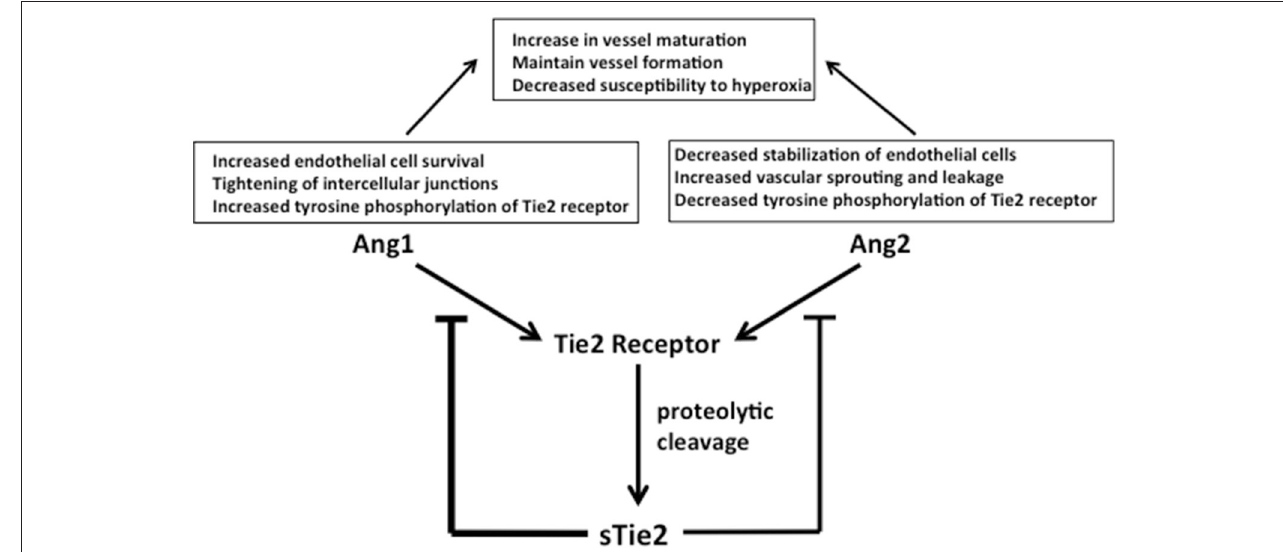
FIGURE 4 | Ang1 and Ang2 function and regulation. Ang1 and Ang2 control competitive regulatory events in the vascular endothelium. Competitive binding to their common receptor, Tie2, regulates endothelial cell stability and function to inhibit or promote neoangiogenesis, respectively. Ang1 increases endothelial cell survival, tightens intercellular junctions, and increases tyrosine phosphorylation of membrane-bound Tie2. Ang2 decreases endothelial cell stability, increases vascular sprouting and leakage, and decreases tyrosine phosphorylation of Tie2, promoting angiogenesis. The resulting competitive signals combine to stabilize formed vessels, allowing them to mature, and simultaneously maintain neovascularization as dictated by tissue oxygen needs. The amounts of free Ang1 and Ang2 available for binding Tie2 are modulated by soluble Tie2 (sTie2), which is formed by proteolytic cleavage and release of the extracellular component of the membrane bound Tie 2 receptor. Circulating sTie2 binds both Ang1 and Ang2, making them unavailable for binding Tie2 to influence endothelial cell functions. Because sTie2 has a higher affinity for Ang1 than Ang 2 the amount of sTie2 exerts differential control of Ang1 and Ang2 effects. Increased levels of sTie2 favor an overall increase in new vessel sprouting because more Ang1 than Ang2 is bound up. Abbreviations are as documented in